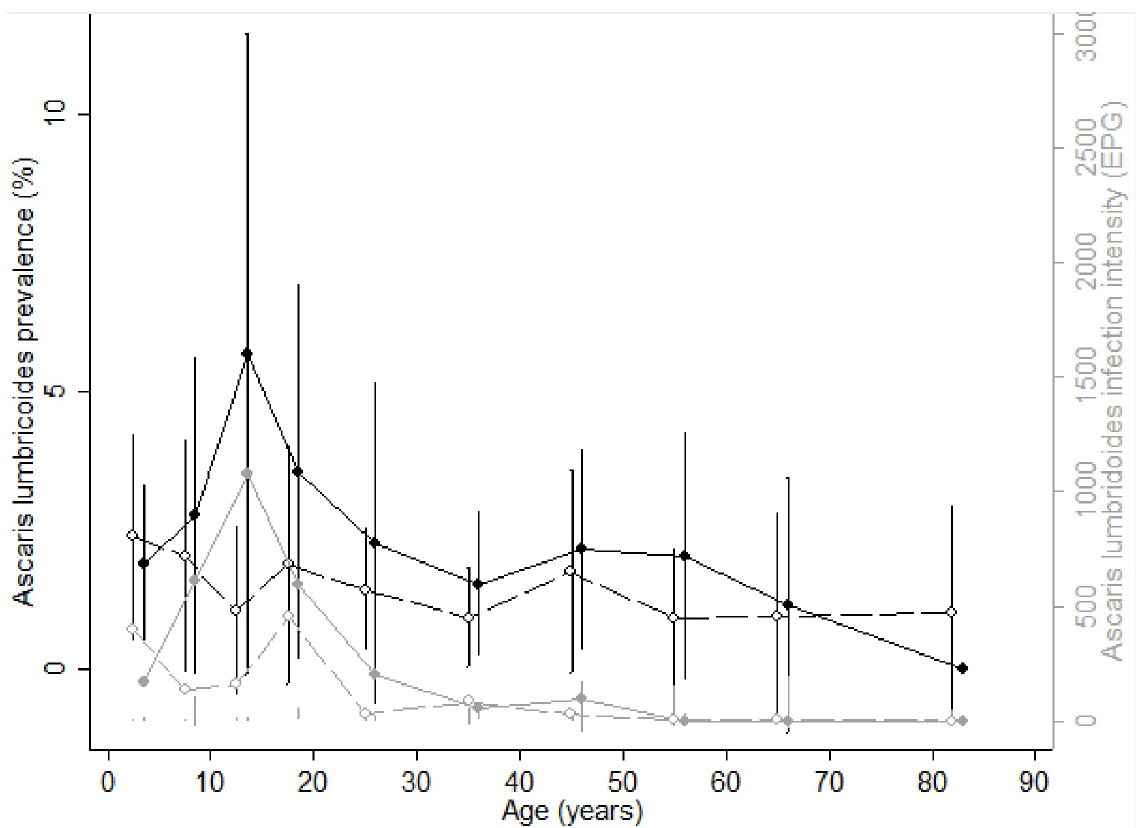
Fig 5. Age-infection profiles for Ascaris lumbricoides . (A) Prevalence (black lines) and intensity (grey lines) of Ascaris infection by age for males (solid line and circles) and females (dashed lines and empty circles). Vertical bars represent confidence